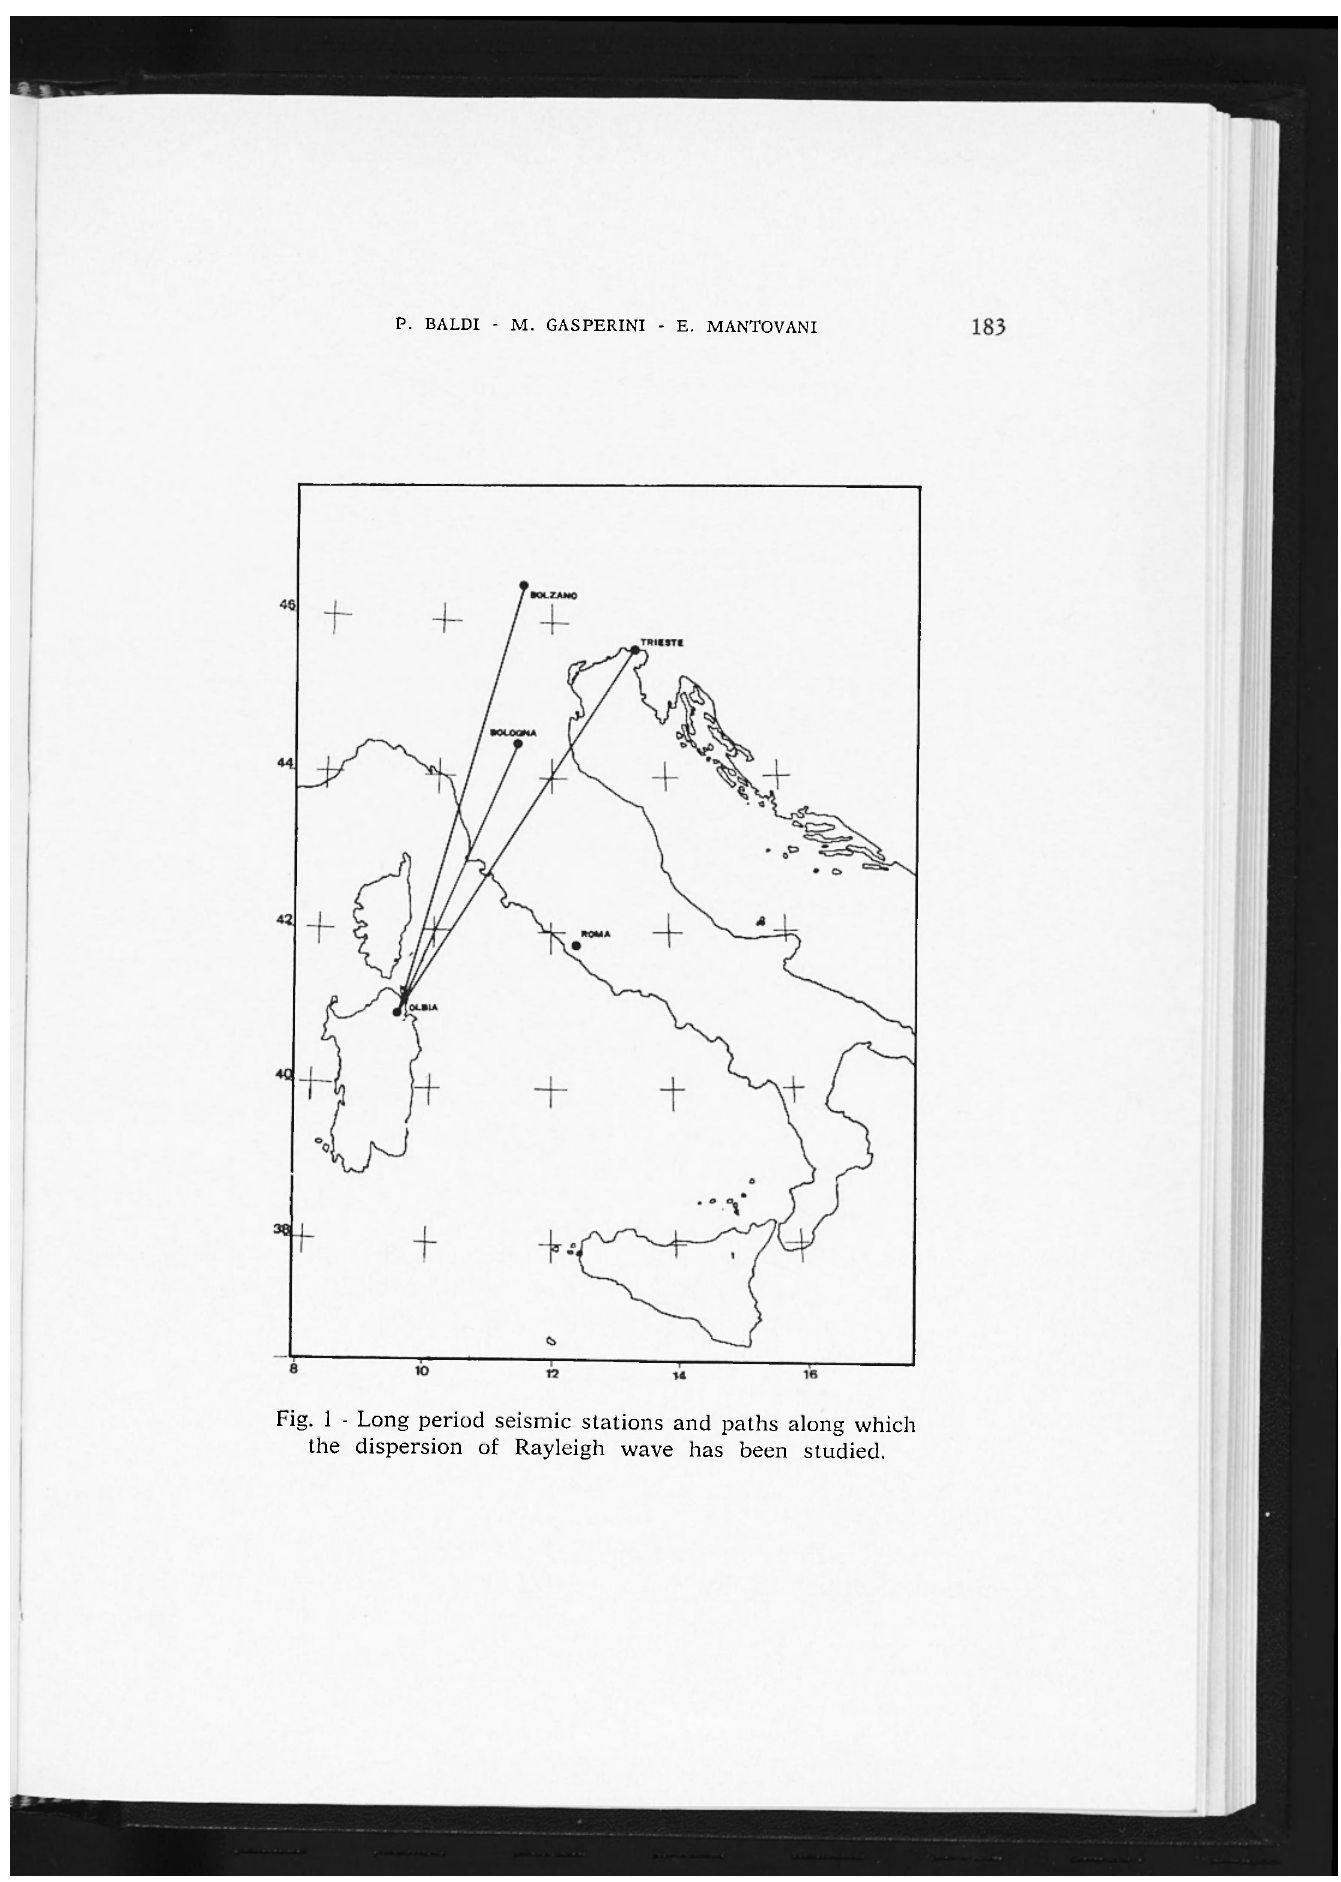
Fig. 1 - Long period seismic stations and paths along which the dispersion of Rayleigh wave has been